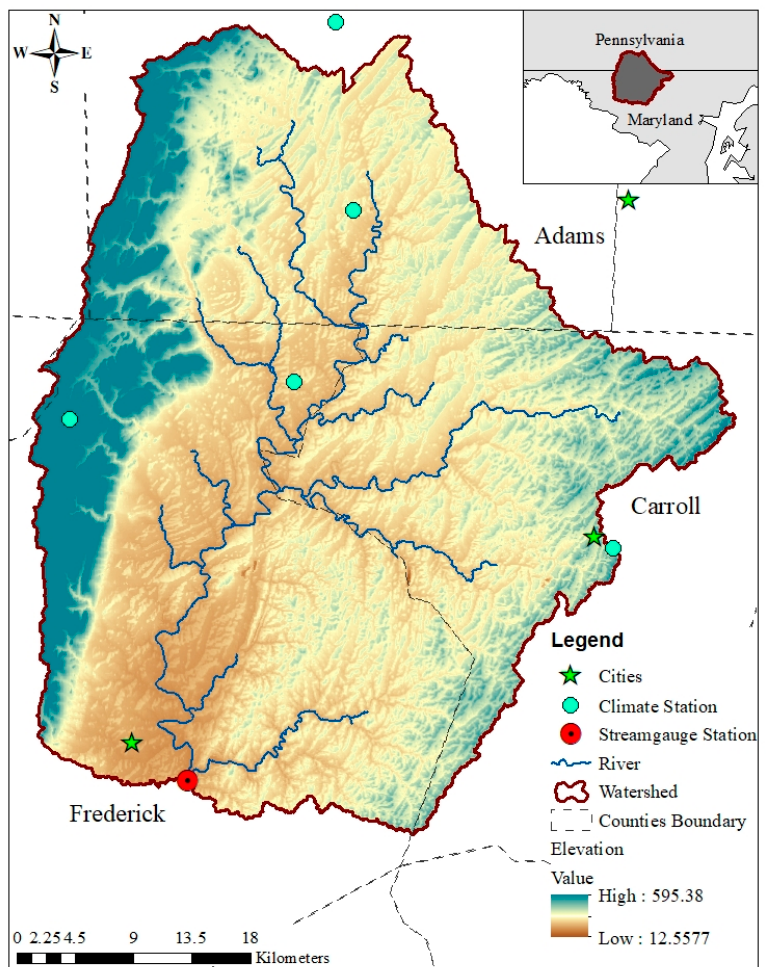
Figure 1. Generated map of the Monocacy River Watershed with selected weather stations and the US Geological Survey streamflow gauge stations at respective watershed outlets.